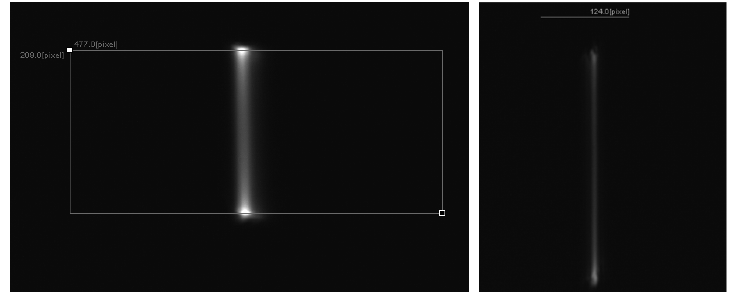
Figure 5. Tip displacements for two different samples using a STC-MBE132U3V camera.